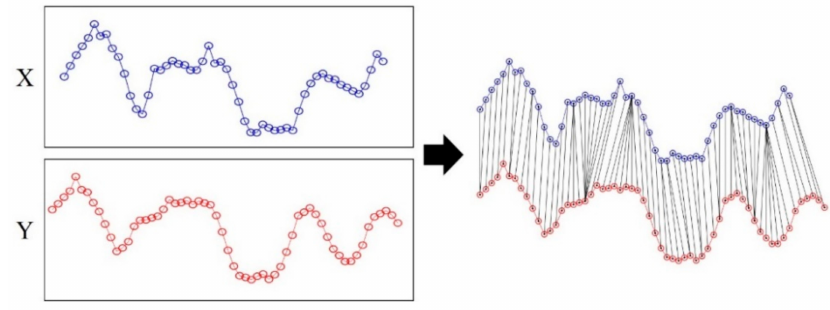
Figure 9. Two sequences connected by optimal path.